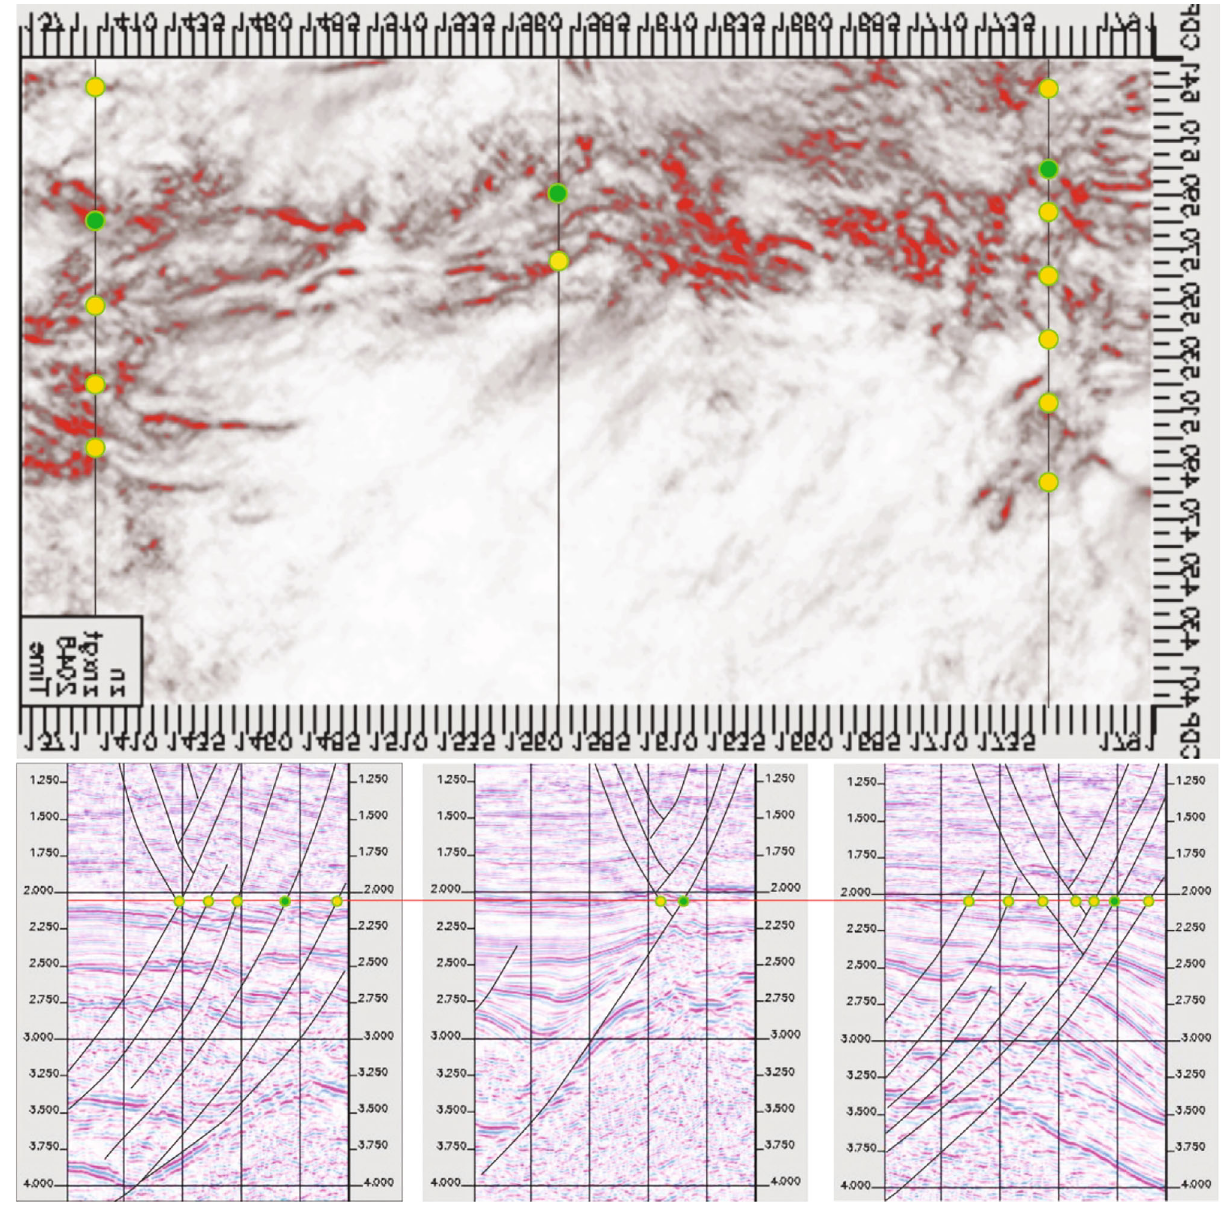
Figure 2: Fault interpretation on coherent slice and seismic time slices. Table 1: Major fault elements of the western